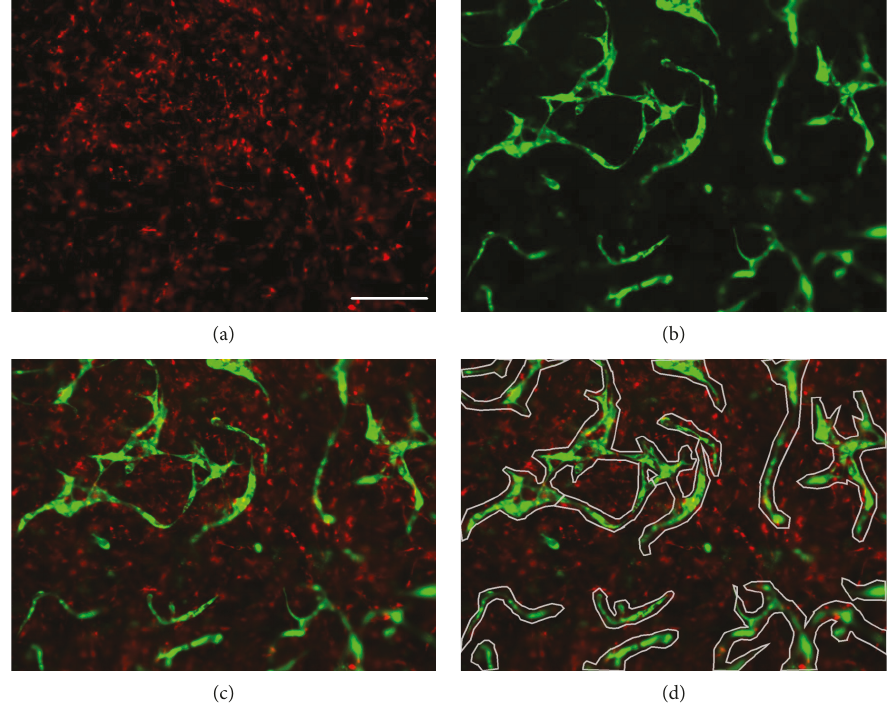
Figure 1: Network analysis. Image analysis method of PRP gels (seeding density: 2.5 × 10 3 cells/ μ l gel) with encapsulated PKH26 Red-labeled MSCs and GFP-HUVECs (green). Shown are representative pictures of a 50% HUVEC – 50% MSC coculture after 14 days of culture. (a) Red-labeled MSCs, (b) GFP-labeled HUVECs, and (c) combined image. (d) Tubular structures are marked with the polygons (grey). Scale bar =200 μ